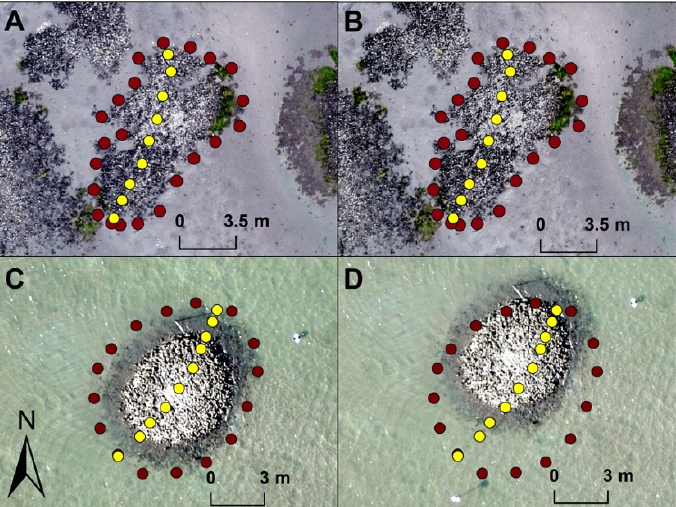
Figure 3. Comparison of oyster reef location between sites and the use of ground control points (GCPs) to correct horizontal accuracy of UAS imagery. ( A ) A fixed-wing eBee flight over Town Marsh reefs processed with GCPs and ( B ) without GCPs. ( C ) An eBee flight over Middle Marsh reefs processed with GCPs and ( D ) without GCPs. RTK-GPS measurements of the reef crest (yellow points) and perimeter (red points) are included for location reference.